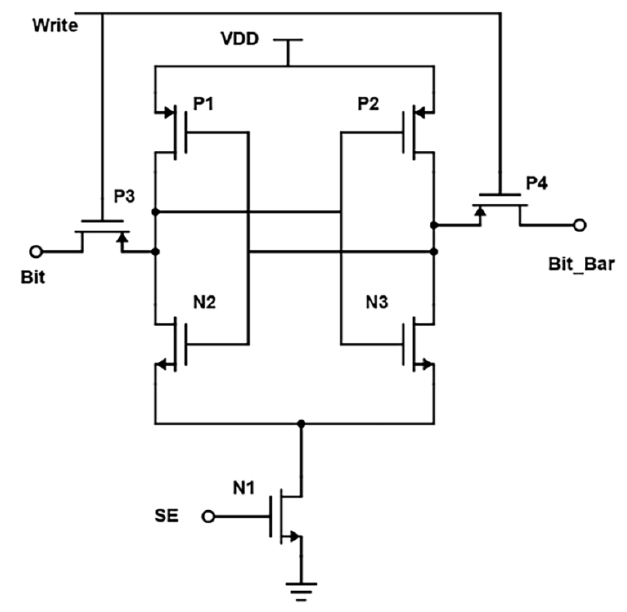
Figure 10. Schematic of the cross-coupled sense amplifier. Simulations with varying sizes of transistors demonstrate that the cross-coupled transistors P1 and P2 largely lock this unbalanced configuration, even when the column select signal CS drops again. In the previous study, it was believed that nodes had equivalent voltages. [1]. This 6T-SRAM circuit is designed using CMOS inverters. This design helps them in making the least power dissipation. At the micro-scale, the major challenge is the leakage current. Output terminals are used as internal lines or bitlines to store bits of data. The output terminals complement each other in this design, as shown in Figure 10. The power consumption spectrum of the cross-coupled sense amplifier is shown in Figure 11.